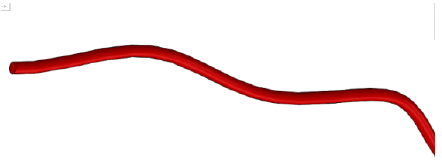
Figure 19. Model of a deformed orthodontic wire.